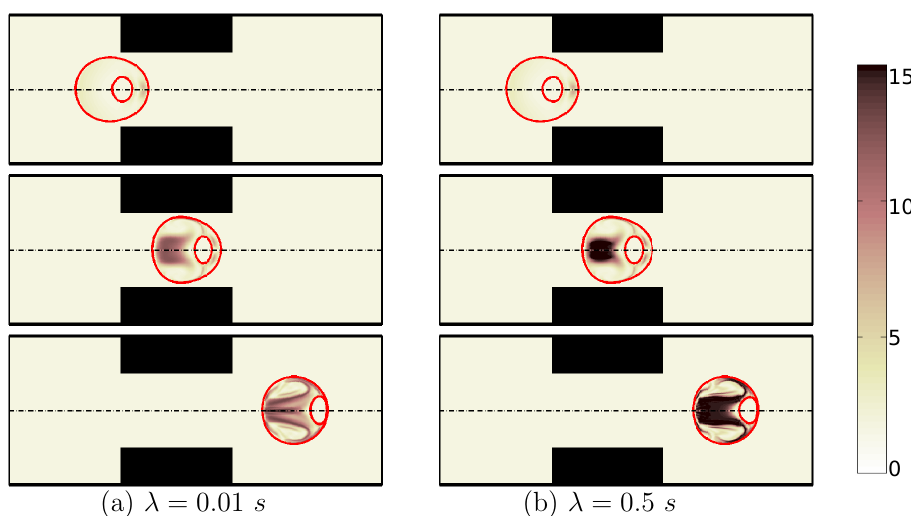
Figure 3. Shape evolution of an encapsulated HL60 cell through the constricted microchannel at different locations of channel. The shell fluid relaxation time is: λ = 0.01 ( a ) and λ = 0.5 s ( b ). The polymeric viscosity ratio is fixed at β = 0.5. The color bar and contours represent the square root of trace of conformation tensor inside the cell and the shell fluid ( Ca = 0.00076 and Re = 0.37).